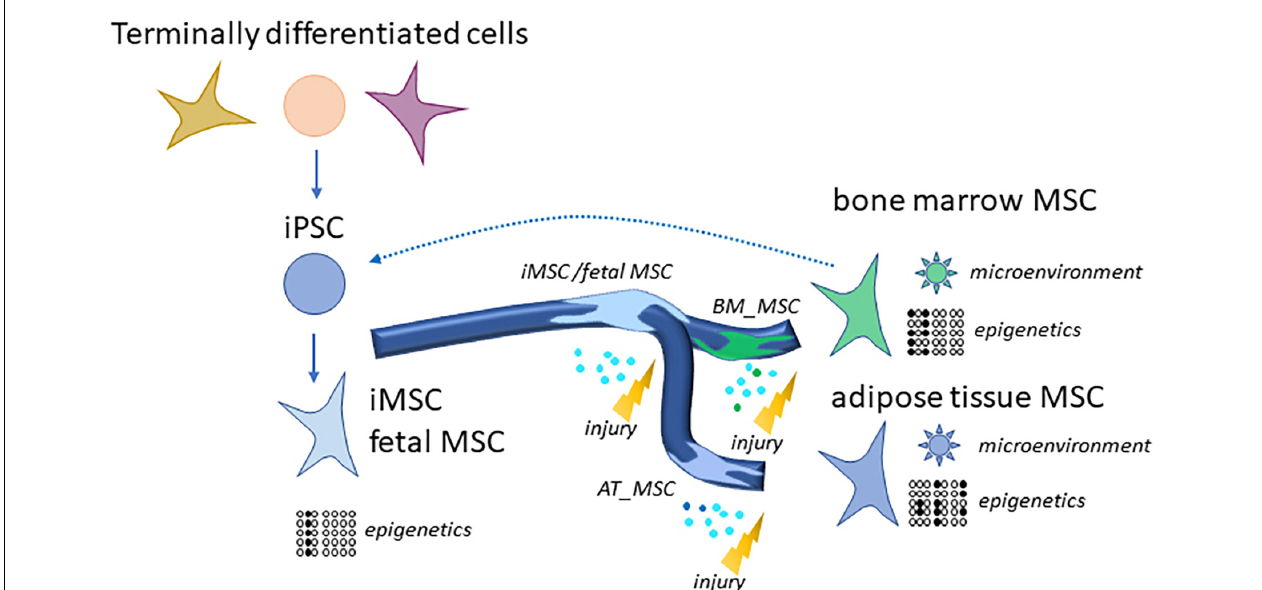
FIGURE 7 | Generation of rejuvenated and more homogenous iMSCs via reprogramming of MSCs or terminally differentiated cells to iPSCs. Distinct MSC subpopulations such as bone marrow MSCs and adipose tissue MSCs have high levels of heterogeneity due to their microenvironments and epigenetic programs. This gets more similar as well as rejuvenated in iMSCs. MSCs as well as iMSCs home into sites of injury and exert beneficial effects which are predominantly due to paracrine signaling and are even superior for the iMSCs as several studies